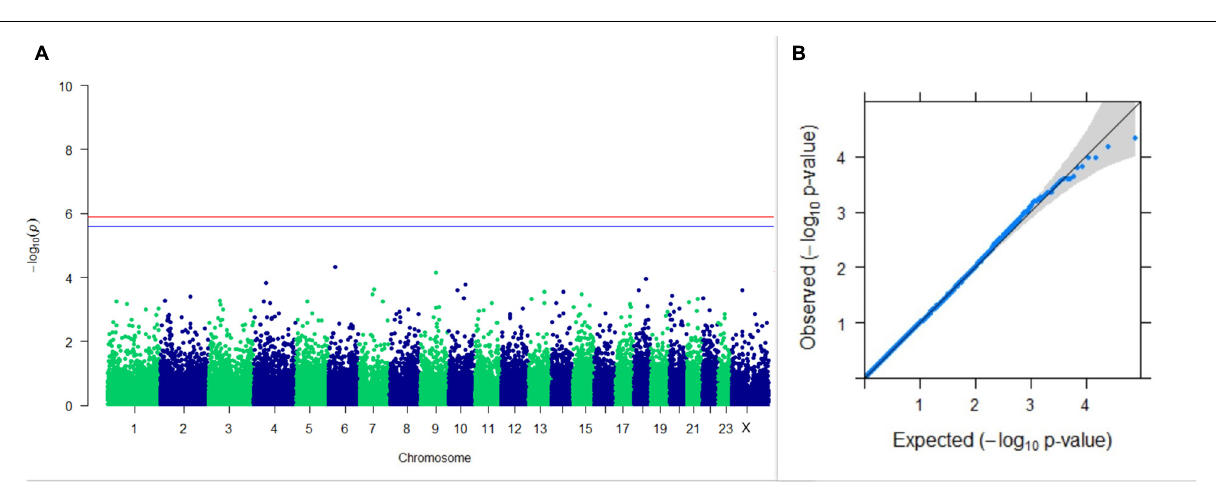
FIGURE 10 | Results of GWAS for lactation persistency according to Ludwick and Peterson. (A) Manhattan plot of genome-wide SNPs. The red line indicates the p- value threshold (expressed as –log 10 P ) corresponding to FDR-corrected p- values or q = 0.05, above which the SNPs are considered to be significantly associated with the trait, while the blue line indicates the genome-wide suggestive threshold at q = 0.1. The SNPs identified on chromosome no. 24 were screened out from analysis because of stringent quality control; hence, it is not represented in the Manhattan plot. (B) Q-Q plot of the p-